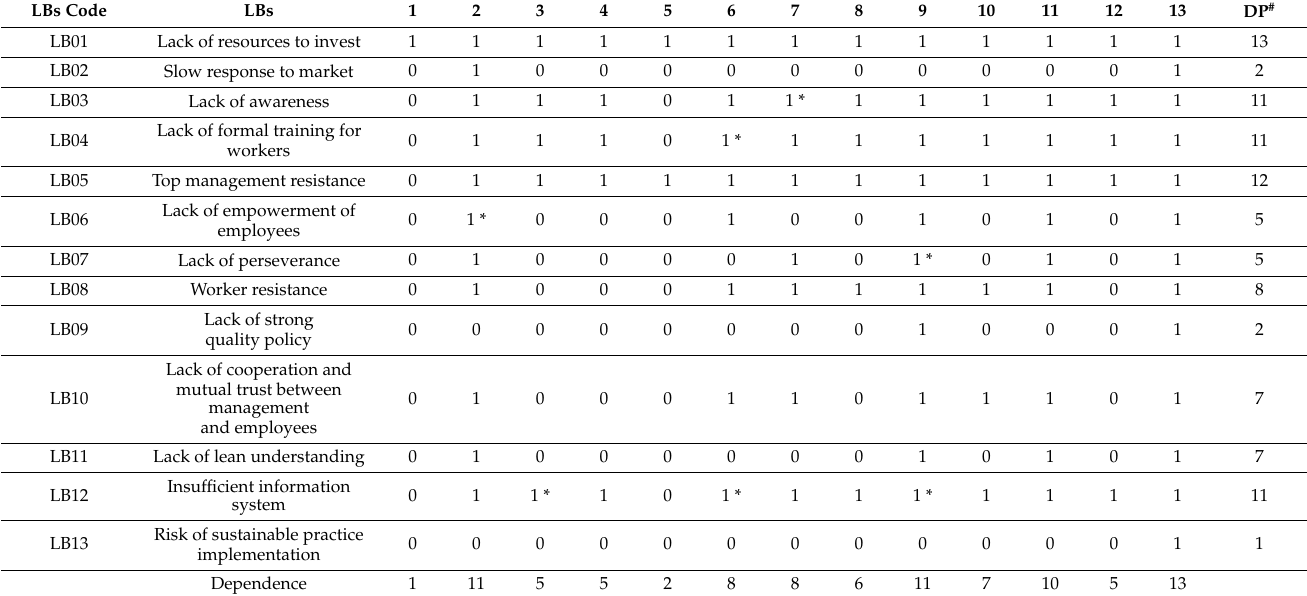
Table 5. Final reachability matrix